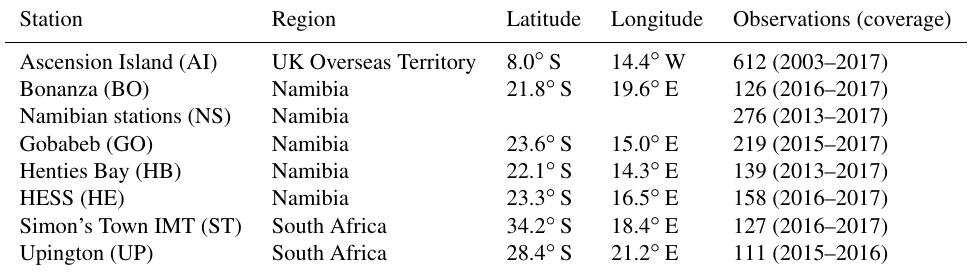
Table 1. AERONET stations used in this study, with locations and data availability (AERONET Version 3 Direct Sun algorithm, level 2). IMT is the Institute for Maritime